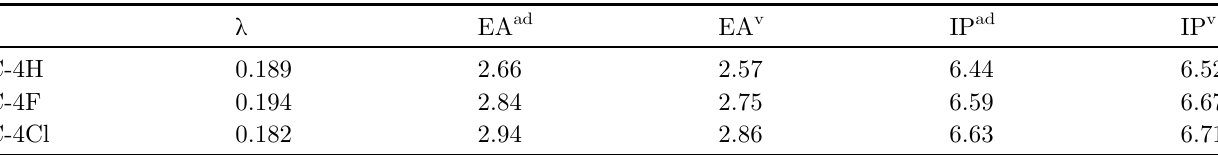
Table 1. Calculated reorganization energies ( λ ), vertical and adiabatic electron af fi nities (EA) as well as ionization potentials (IP) in eV.